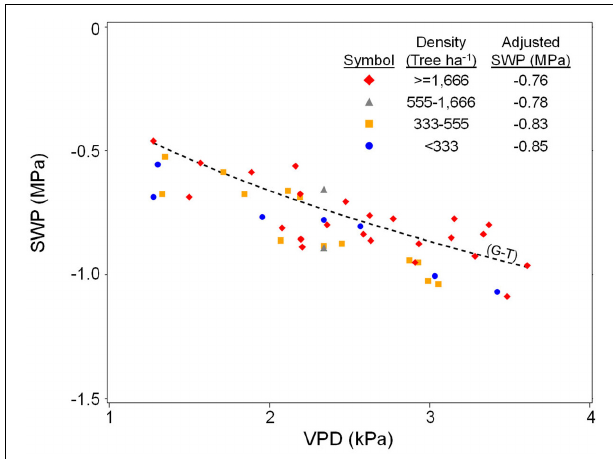
FIGURE 5 | Relation of SWP to VPD for all individual points of the upper 0.07 fraction, classified into groups representing different orchard tree densities, and the adjusted SWP means corresponding to each group. Also shown for reference is the linear/exponential fit for the García-Tejera et al. (2021, GT) SHD model (also shown in Figure 4